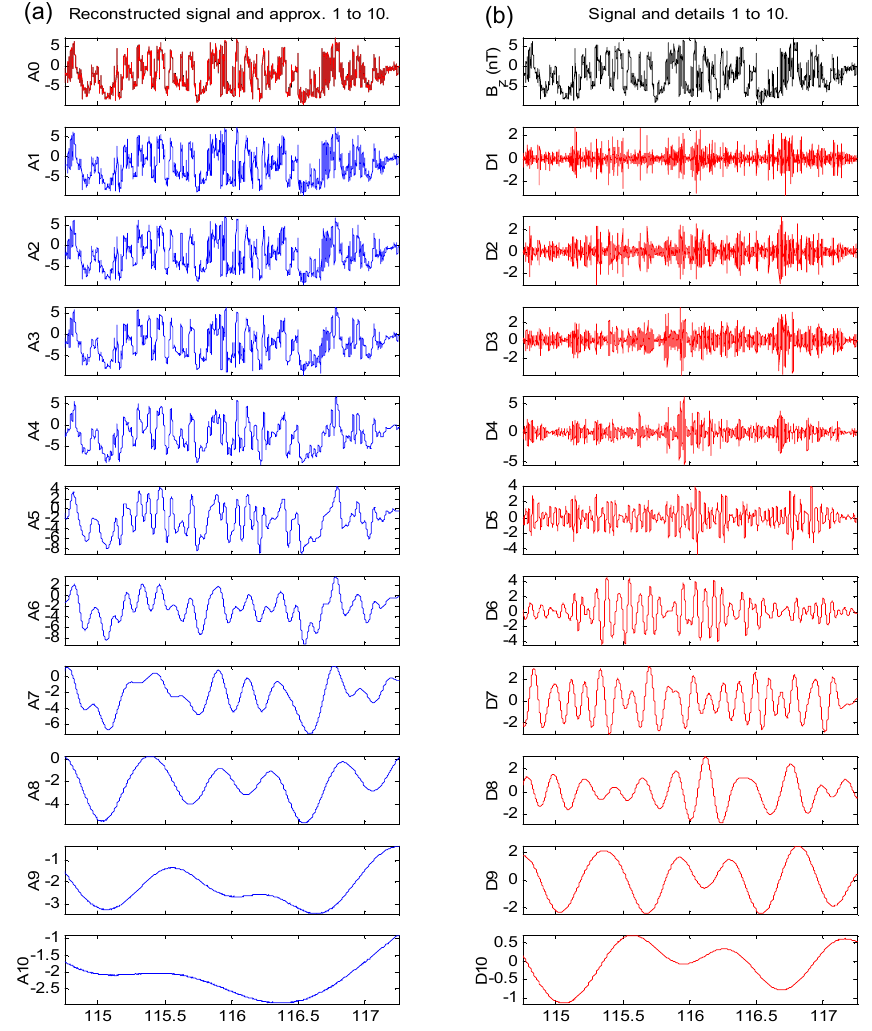
Figure 2. Wavelet decomposition on the interplanetary magnetic field B z component for event 1_1998. The right panels show the details (bands) and the left panels show the approximations